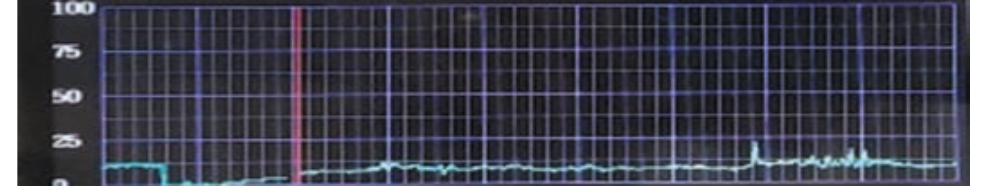
Fig. 3 Non-invasive tocodynamic monitoring-Partial primary uterine intertia